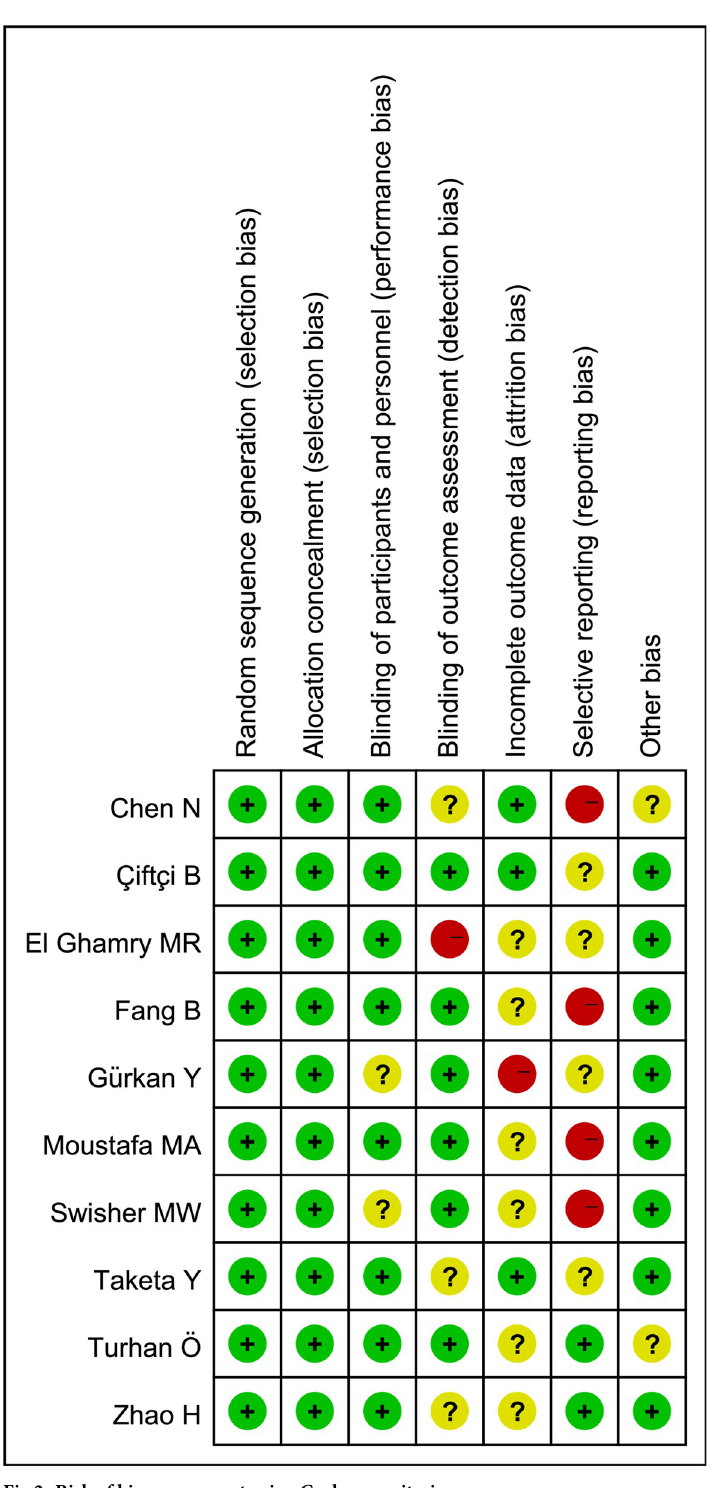
pooled analysis revealed that when compared to ESPB, PVB resulted in significant statistical